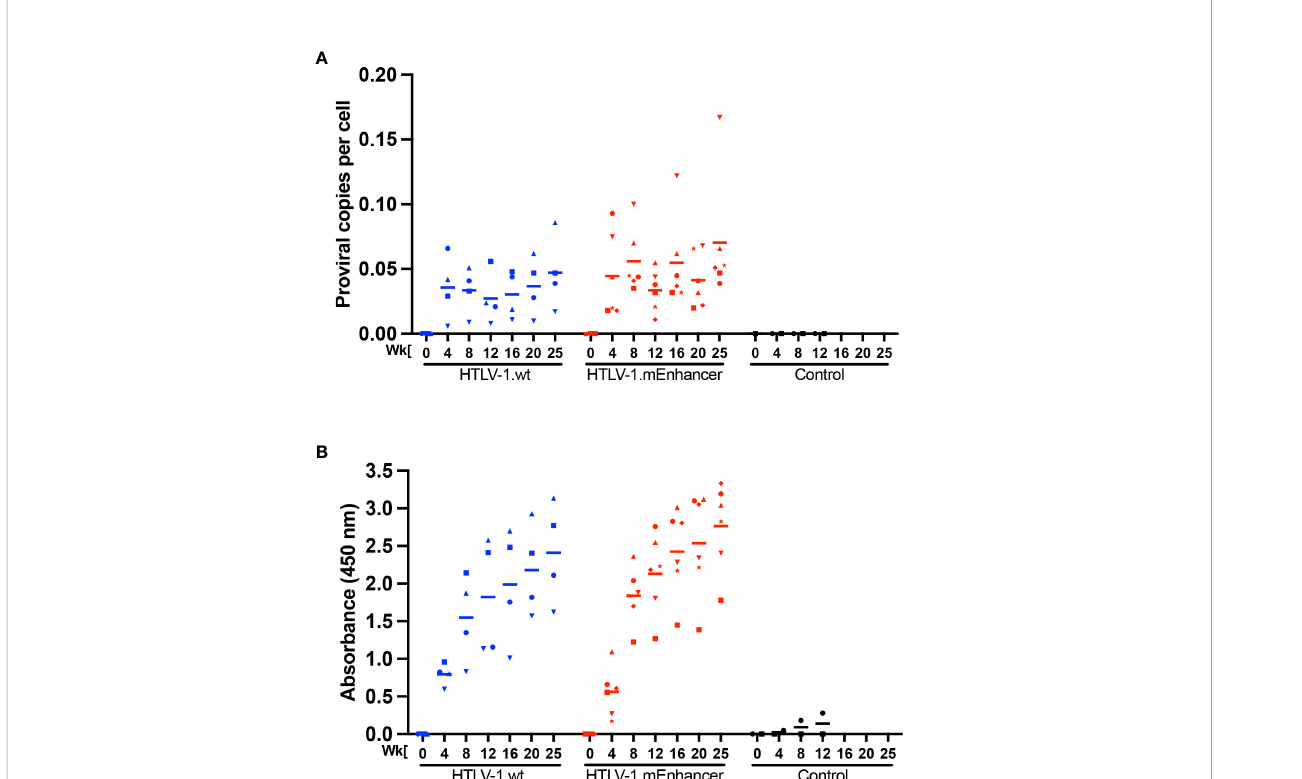
FIGURE 3 HTLV-1 enhancer element is dispensable for early in vivo viral persistence. Lethally irradiated 729 HTLV-1.wt or 729 HTLV-1.mEnhancer producer cells were inoculated into 14-week-old, male New Zealand white rabbits via the lateral ear vein. Blood was collected at Week 0 (pre- inoculation) and Weeks 4, 8, 12, 16, 20, and 25 post-infection (study endpoint) for plasma and rabbit PBMC (rPBMC) isolation. (A) Genomic DNA was isolated from rPBMCs and subjected to qPCR to detect proviral load using a primer and probe set speci fi c to HTLV-1 Gag/pol. (B) Plasma was isolated from whole blood to measure the HTLV-speci fi c antibody response using the Avioq HTLV-I/II Microelisa System. Absorbance was measured at 450 nm. In each of the graphs, unique symbols represent proviral load and antibody response for a single inoculated rabbit over time and bars represent the mean. Linear mixed-effects analyses were performed and multiple comparisons were adjusted by Tukey ’ s